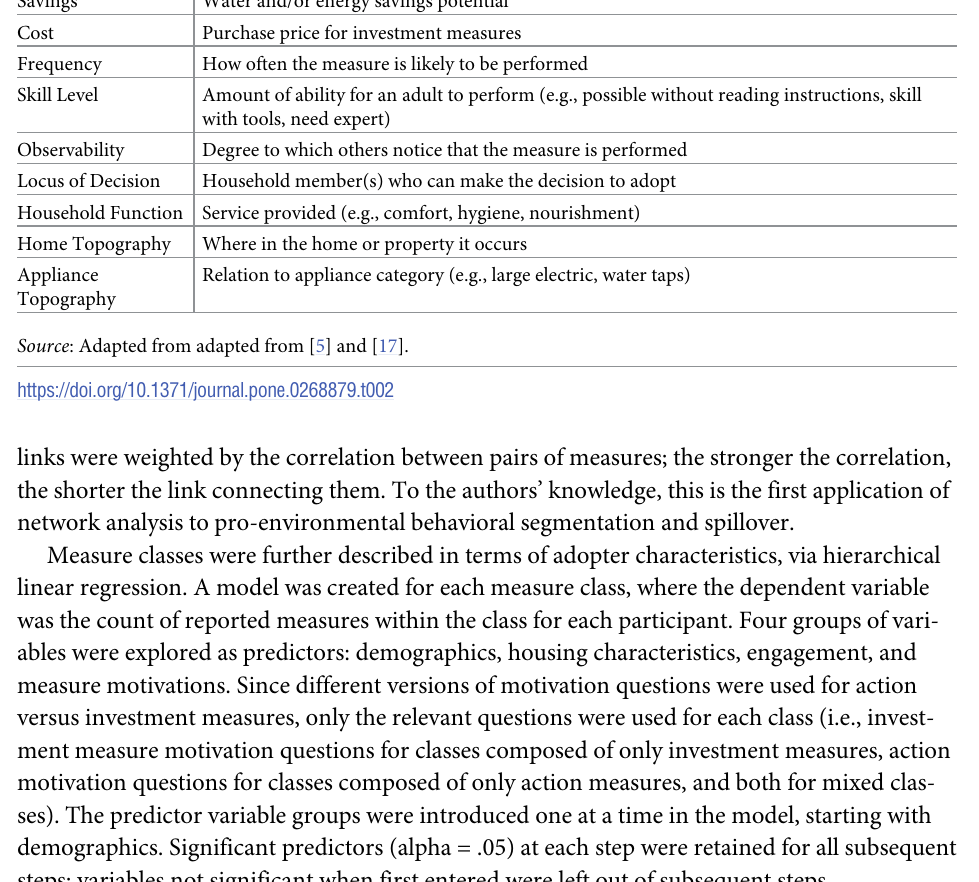
Table 2. Behavioral attributes of energy- and/or water-saving measures. Attribute Description Savings